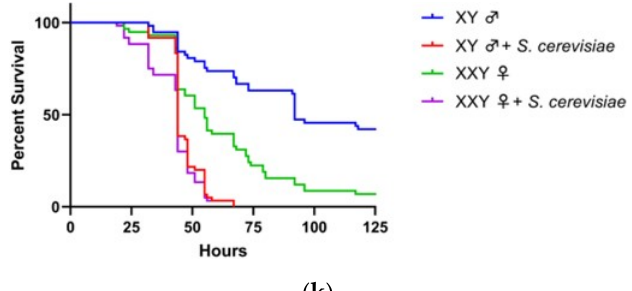
Figure 1. Effects of loss of function of Y ‐ genes or gain of Y chromosome on the sensitivity of fly survival to yeast infection. Wild ‐ type (WT), loss of function Y ‐ mutant males and XXY females (ABO ‐ X2) were orally exposed to a 50 mM sucrose solution containing Saccharomyces cerevisiae . For experiments with wild ‐ type flies, Oregon ‐ R strain was used ( a ). For mutant fly strain experiments involving loss of function of Y ‐ genes, females are wild ‐ type ( b – j ). In the case of XXY females, males are wild ‐ type ( k ). Each condition contains ten flies. Vials are incubated at 30 °C and checked a minimum of twice per day for fly survival (***, p < 0.001; ****, p < 0.0001).